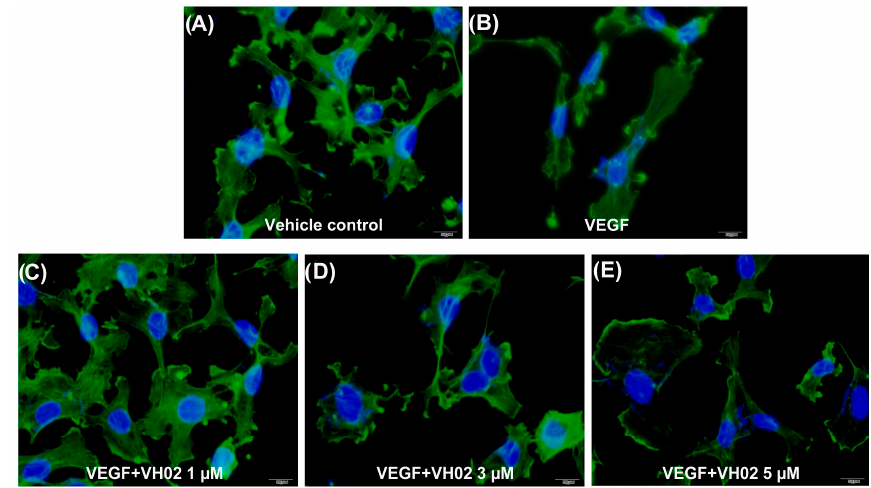
Figure 5. Immunofluorescence images of actin cytoskeleton in EA.hy926. Cells were treated with VH02 for 30 min, and then stimulated with or without VEGF (50 ng/mL) for 15 min. Actin fibers were visualized in cells fixed with 4% formaldehyde and tagged by anti-rabbit conjugated Alexa Fluor (green) as described in the Materials and Methods section. The nuclei were counterstained with DAPI (blue). All images were taken in the same exposure by Olympus immunofluorescence microscopy with 600× magnification. Scale bar = 10 μ m. ( A ) Control cells under basal condition; ( B ) cells treated with VEGF (50 ng/mL); ( C ) cells treated with VH02 (1 μ M) and VEGF (50 ng/mL); ( D ) cells treated with VH02 (3 μ M) and VEGF (50 ng/mL); ( E ) cells treated with VH02 (5 μ M) and VEGF (50 ng/mL).